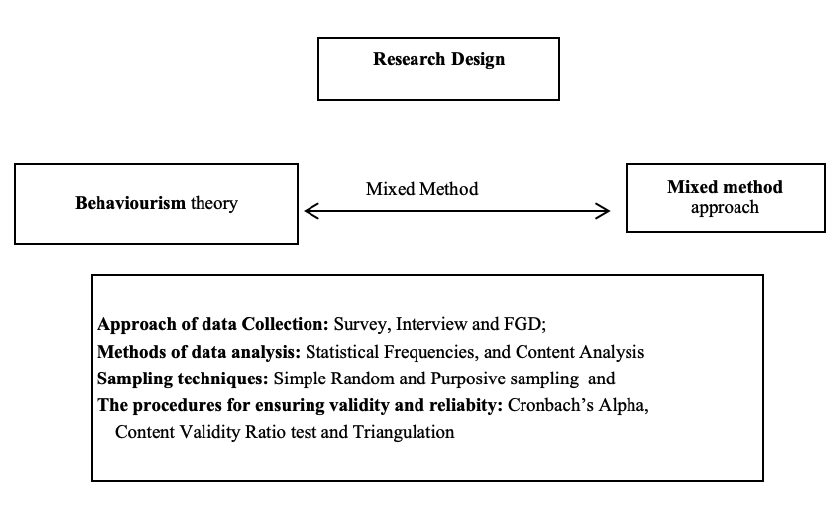
Figure 1: Research Design Framework; Source: Adapted from Creswell,